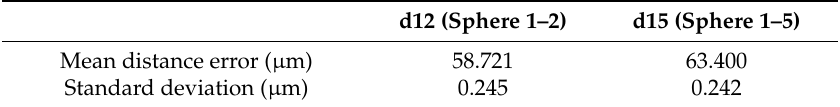
Table 2. Indexed metrology platform uncertainty in a distance measurement, 10,000 iterations.